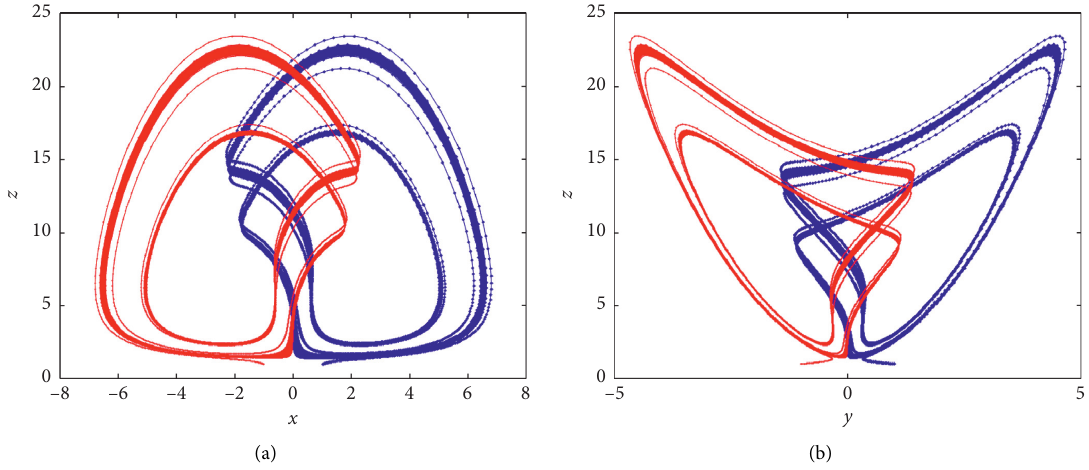
Figure 27: Coexisting attractors in ( x, z )( y,z ) planes at α � 0 .